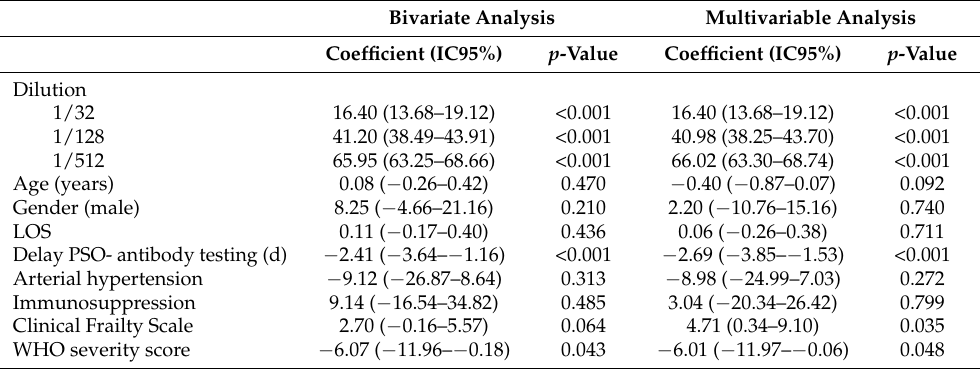
Table 3. Factors associated with the development of SARS-CoV-2 fiAbs indirectly measured with fusion assessed with bivariate and multivariable multiple-mixed linear